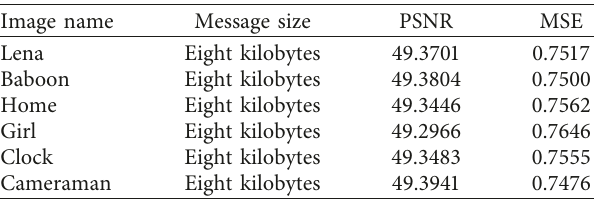
Table 3: Performance analysis of the proposed method using (256 256) images. ∗